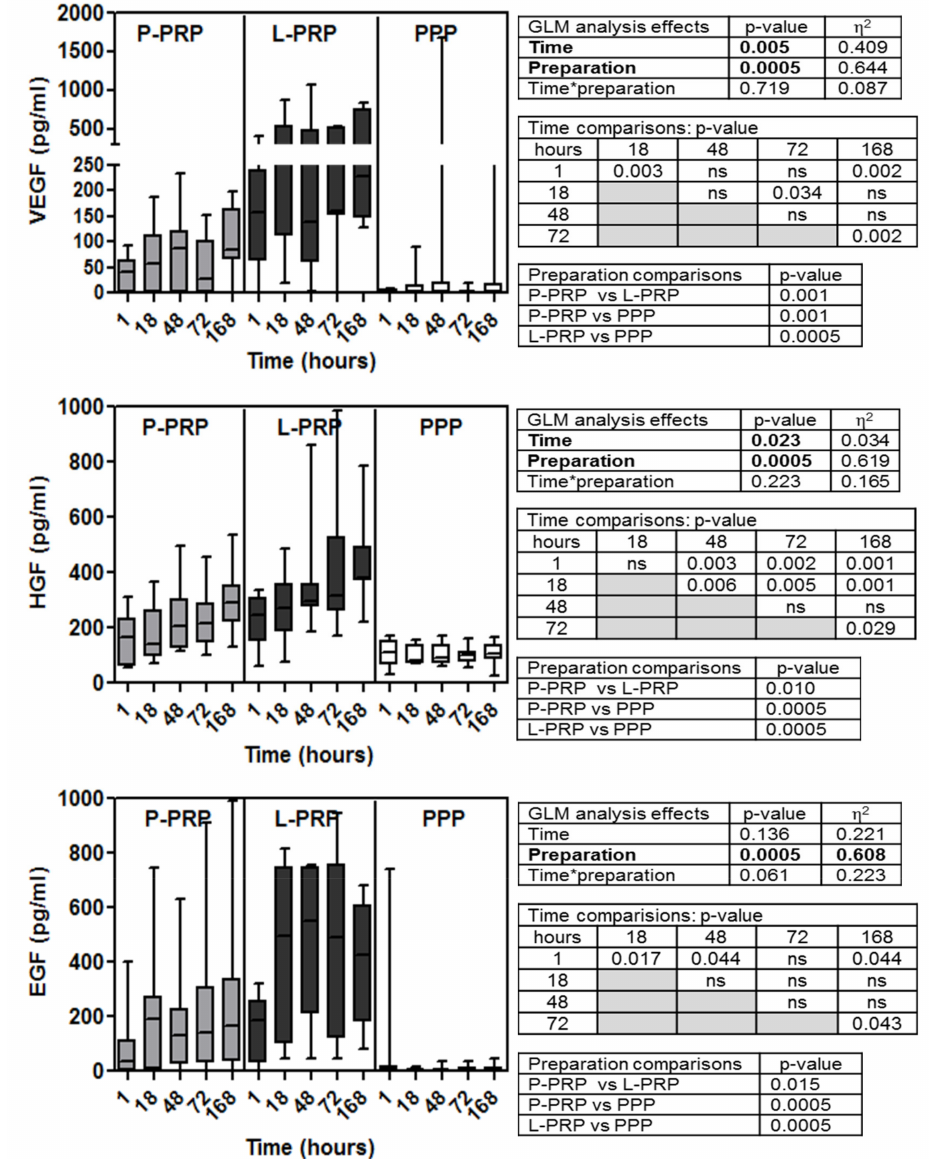
Figure 2. Concentrations of VEGF, HGF and EGF molecules in P-PRP, L-PRP, and PPP. Results are reported as medians (bars), 25th and 75th percentiles (boxes), and minimum to maximum values (whiskers); p value significances are reported in tables on the right side of each graph, as determined by general linear mode statistical analysis (bold); * variable association; ns, not